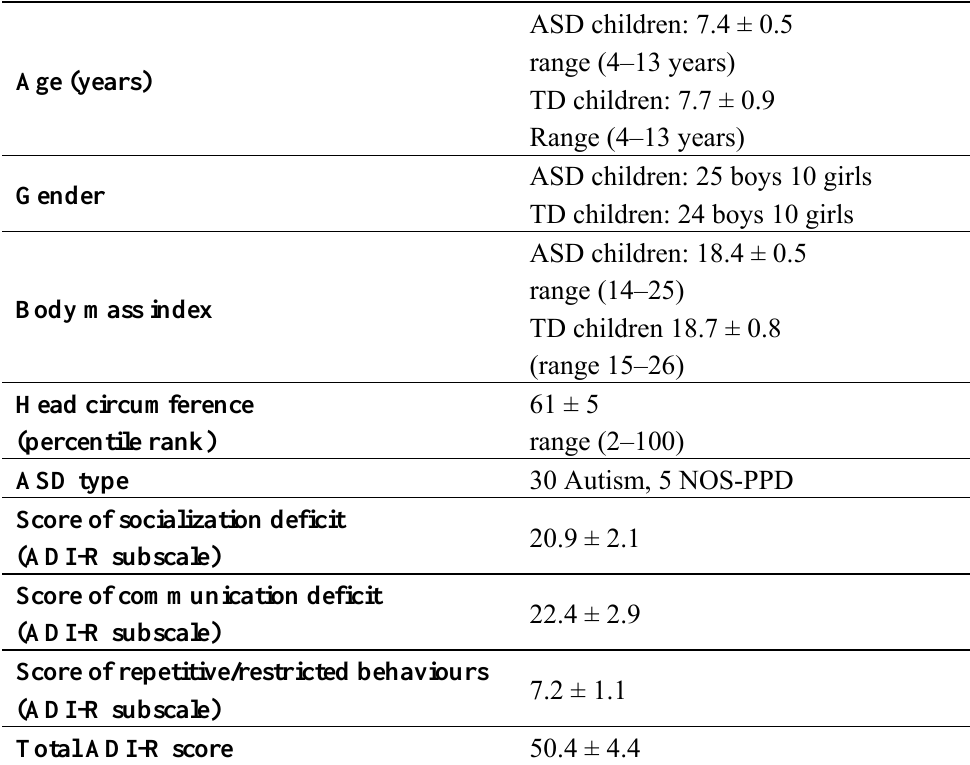
Table 1. Demographic, morphometric and clinical features of the study